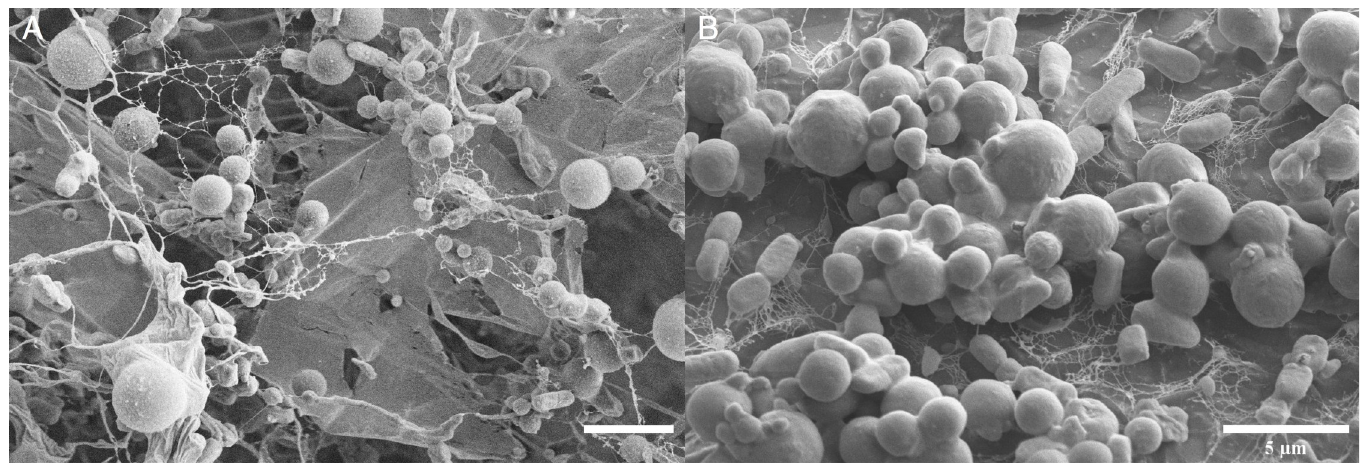
Fig 3. Cryo-SEM analysis of Synechococcus sp . PCC 7002 on a) polyethylene nanoparticles and b) polyethylene microparticles with EPS fibril structure highlighted. Scale bars = 5 μ m.